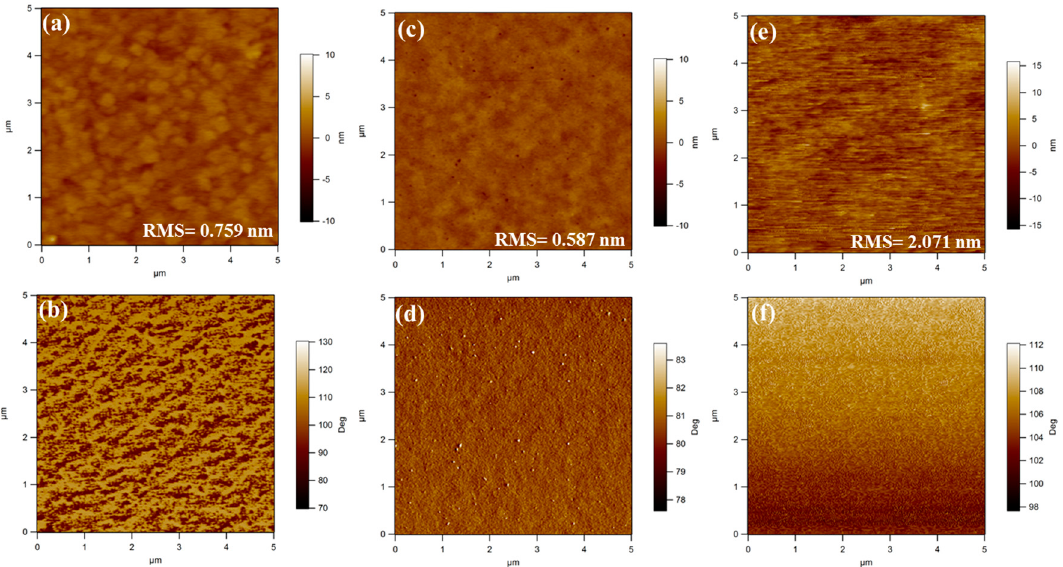
Figure 9. Tapping atomic force microscopy (AFM) height (top) and phase (bottom) images for photoactive layers of PIDTT-DTBT/PC 61 BM (1:2, 0%DIO, ( a , b )), PIDTT-TBT/PC 71 BM (1:2, 3%DIO, ( c , d )) and PIDTT-TFBT/PC 61 BM (1:2, 3%DIO, ( e , f )). Image size: 5 μ m × 5 μ m.